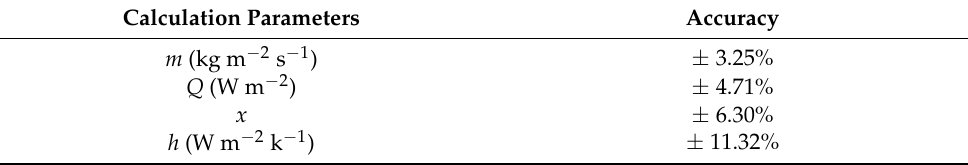
Table 3. Accuracy of the calculated